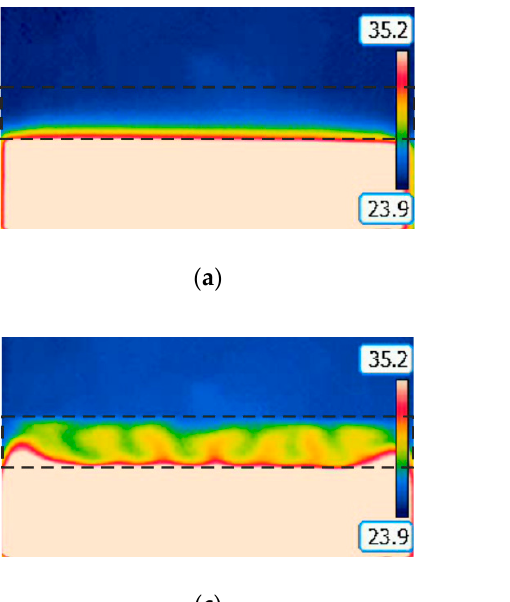
Figure 5. The temperature of the bottom (heated) aluminum plate of the cell as a function of time after heating is turned on. The results obtained in the absence and under the influence of a mag- netic field are shown.